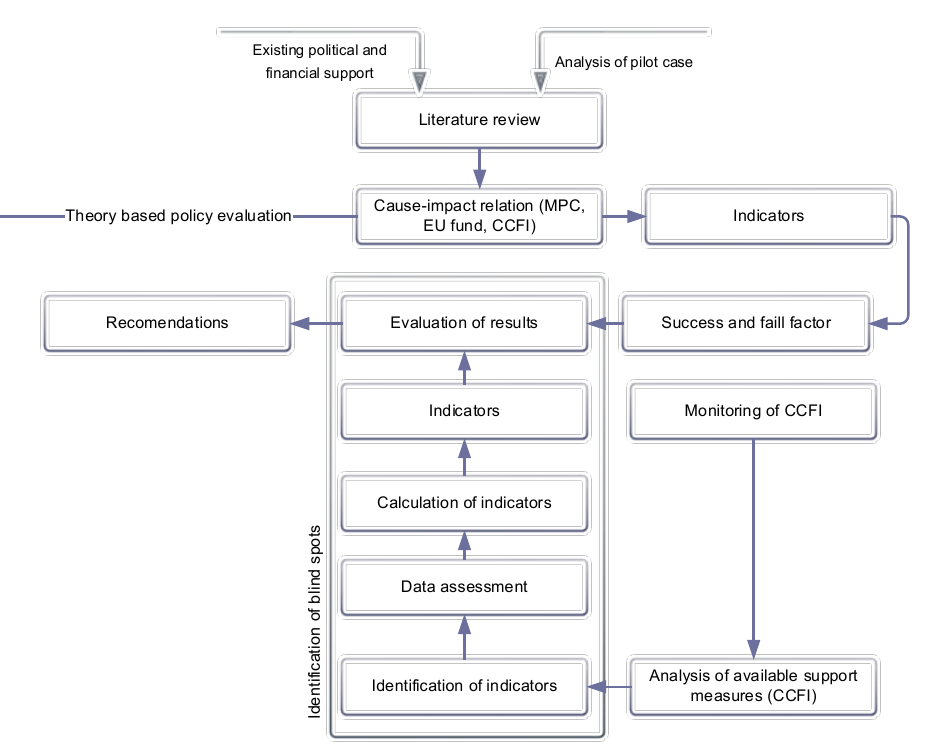
Fig. 2. The algorithm of research